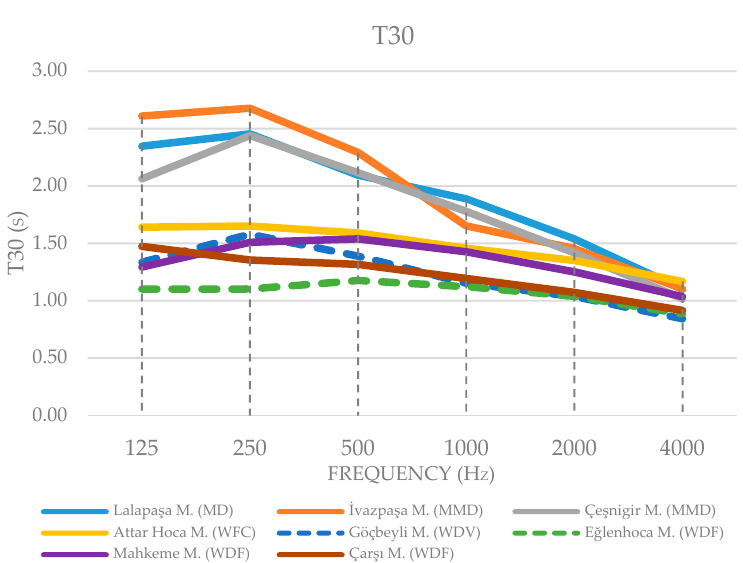
Figure 11. The average values of T30 measured in the eight mosques. (MD; masonry single-domed, MMD; masonry multi-domed, WFC; wooden flat ceiling, WDV; wooden dome and vault, WDF; wooden dome and flat ceiling).